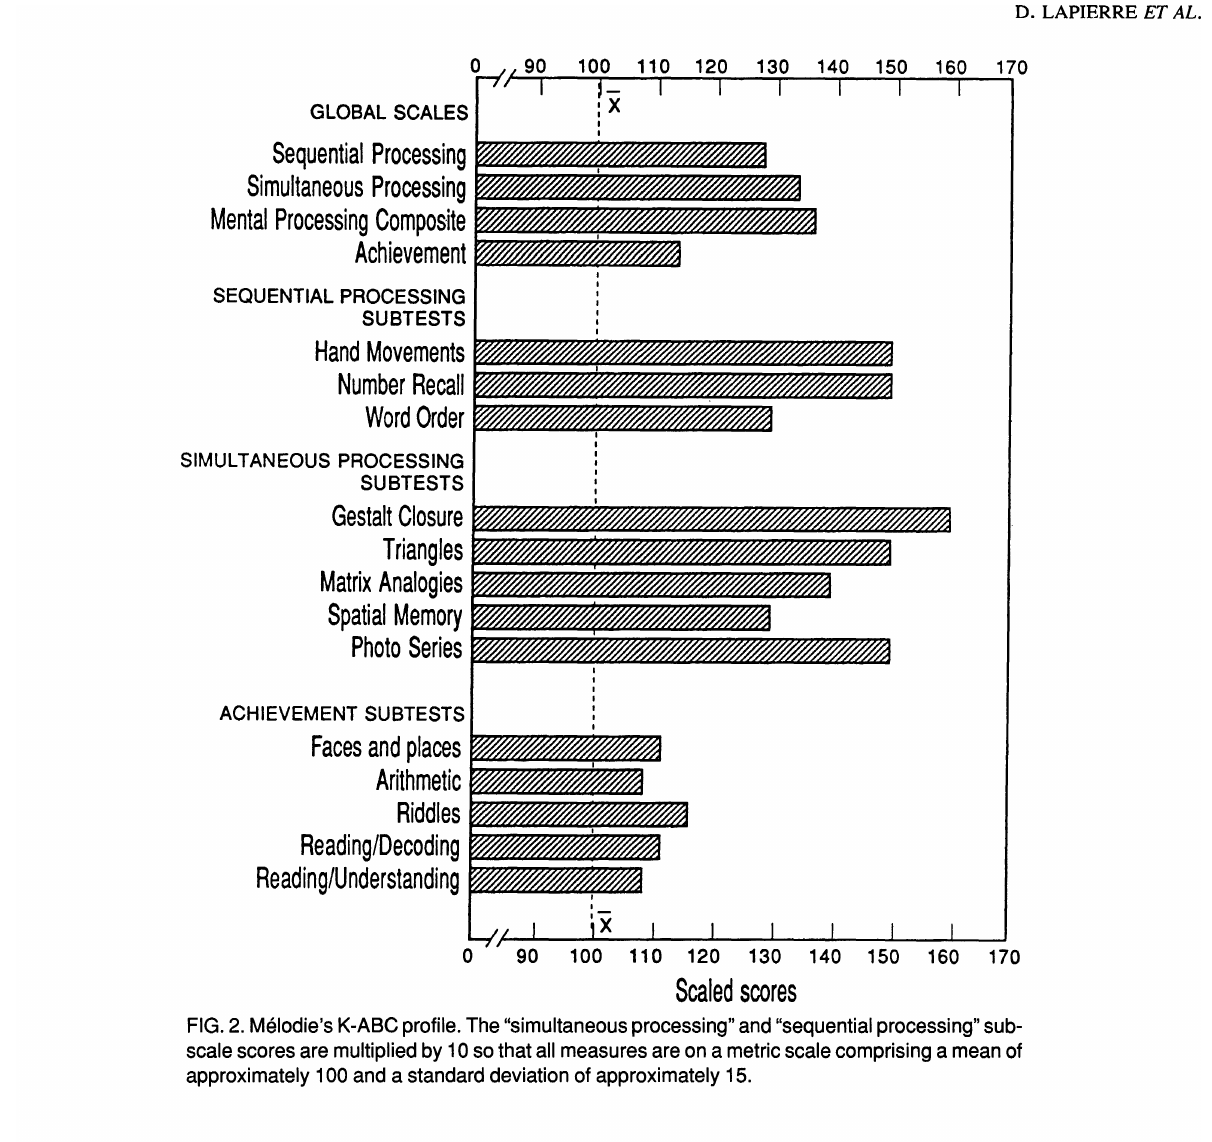
FIG. 2. Melodie's K-ABC profile. The "simultaneous processing" and "sequential processing" sub scale scores are multiplied by 10 so that all measures are on a metric scale comprising a mean of approximately 100 and a standard deviation of approximately